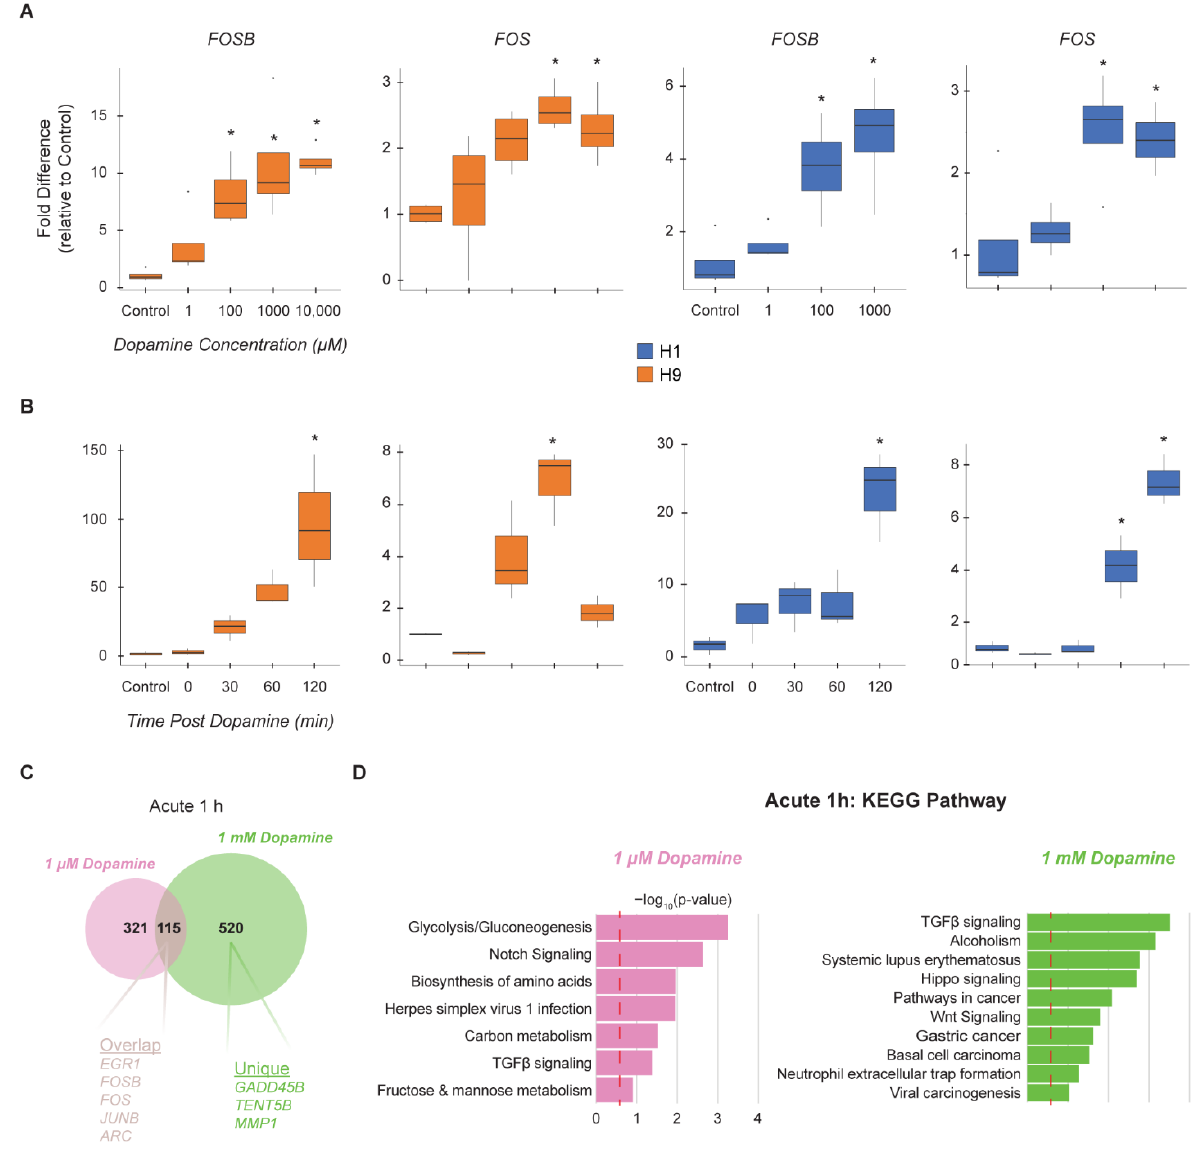
Figure 2. hMSN-like cells exhibit dose and time-dependent responses to dopamine. ( A ) QRT-PCR of RNA isolated from DIV45 H1 and H9 hMSN-like cells 1 h after exposure to different dopamine concentrations (1 µM to 10 mM) and analyzed for FOSB and FOS . ( B ) QRT-PCR of RNA isolated from DIV 45 H1 and H9 hMSN-like cells 0 to 120 min after exposure to 1 mM dopamine and analyzed for FOSB and FOS . ( A , B ) For QRT-PCR, values were normalized to GUSB mRNA levels in the same samples and expressed as a fold change in dopamine versus PBS control cultures. * = p < 0.05; One-way ANOVA. n = 3–4 independent replicates and 2 technical replicates. ( C ) Venn Diagram showing the number of shared differentially expressed genes (DEG) between DIV45 hMSN-like cells quantified by RNA-seq 1 hour after acute 1 µM and 1 mM dopamine. ( D ) Functional enrichment analysis of RNA-seq data for KEGG pathways of DEGs unique to DIV45 1 µM dopamine dosed (left) and 1 mM dosed (right) hMSN-like cells. Significance is represented by Log 10 -transformed p -values. Dotted red line indicates p -value of 0.05. ( C , D ) DEGs were identified by max group mean ≥ 0.75, FDR p -value < 0.05, and Log 2 (Fold Change) > |1|. Differential expression was performed against PBS control group using the Wald test. n = 3 independent replicates.